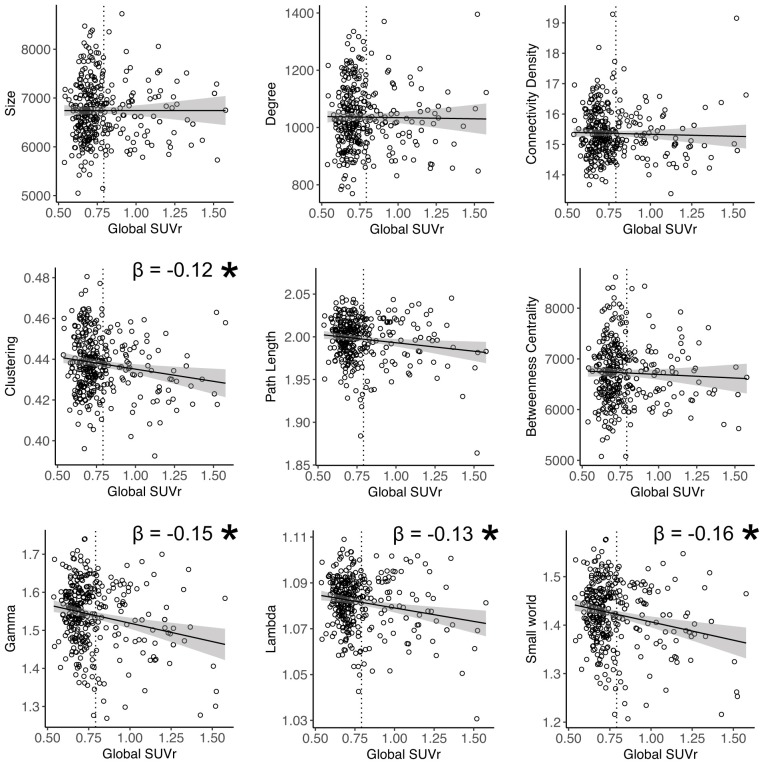
Relation between global amyloid standardized uptake value ratio (SUVr) and whole brain network measures. *Indicates significant relationship after correction for age and gender. Gamma and small world remained significant after additional correction for total gray matter volume (GMV). Dotted vertical line represents the cut-off for amyloid positivity (SUVr > 0.79).